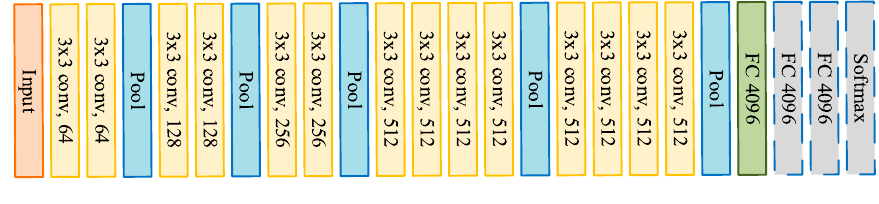
Figure 5. VGG19 network structure.